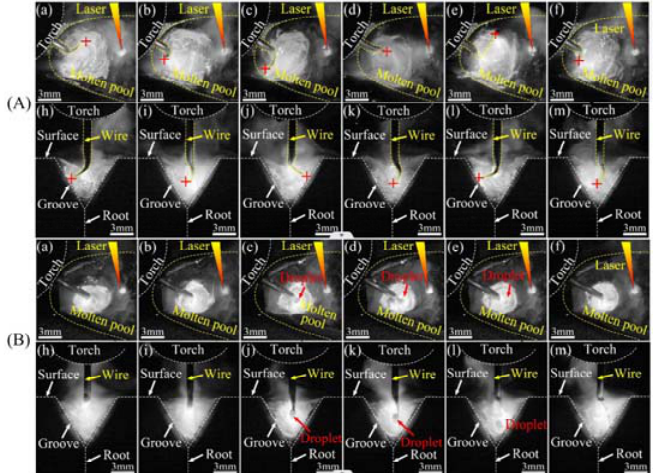
Figure 16. Droplet transfer with different shielding gas: Ar + 30% He ( A ): high ‐ speed images in vertical(a ‐ f) and horizontal(h ‐ m) view and pure He ( B ): high ‐ speed images in vertical(a ‐ f) and horizontal(h ‐ m) view [80]. Reprinted with permission from [80] 2022 Elsevier.